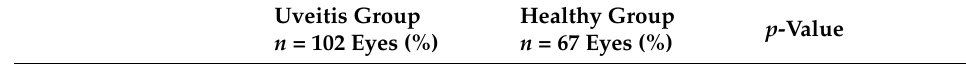
Table 2. Artifact types in uveitis and healthy